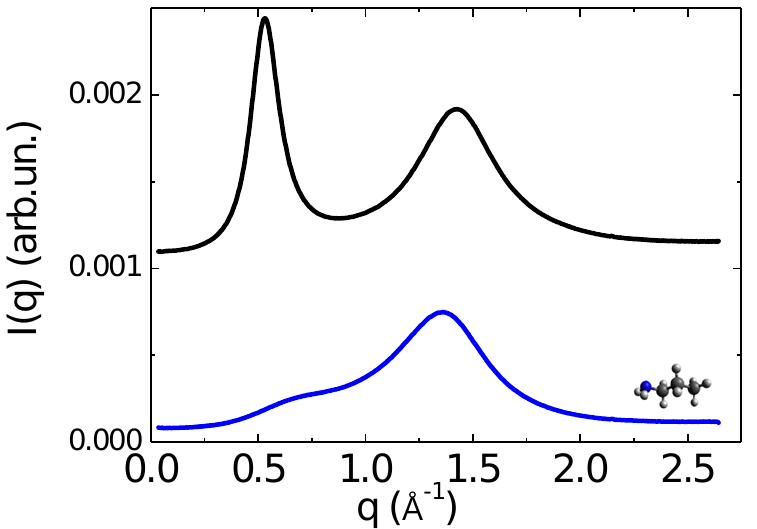
Figure 7. Scattering patterns of a classical liquid (propylamine, with weak intermolecular interac- tions, lower plot) and an ionic liquid (a 1:1 mixture of propylamine and dibutylphosphate, upper plot).